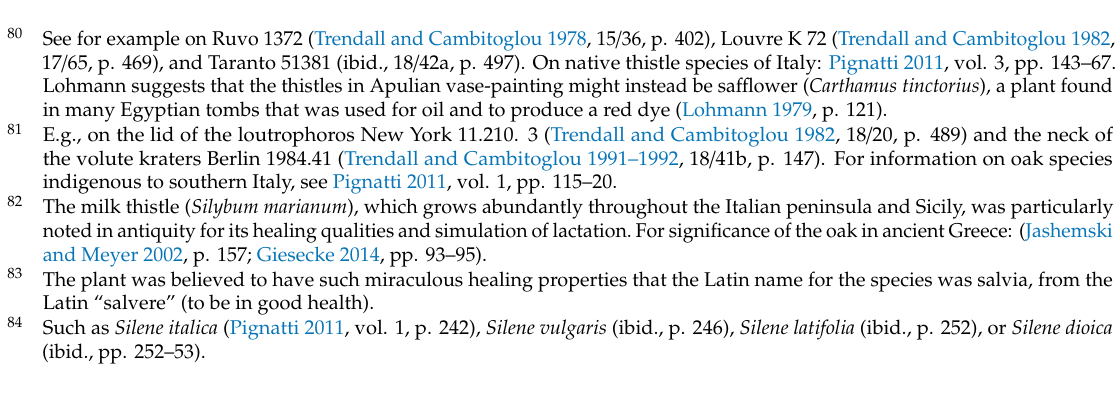
Figure 21. Taranto, Museo Archeologico Nazionale inv. 22437 Gold, carnelian, garnet, and colored